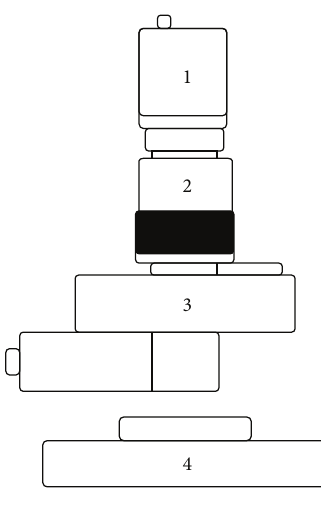
Monochromaticcharged couple device camera (CCD), (2) objective lens, (3) �lter wheel with up to eight optical �lters, (4) base for high power LEDs at different wavelengths (365, 405, 470, and 530nm) for